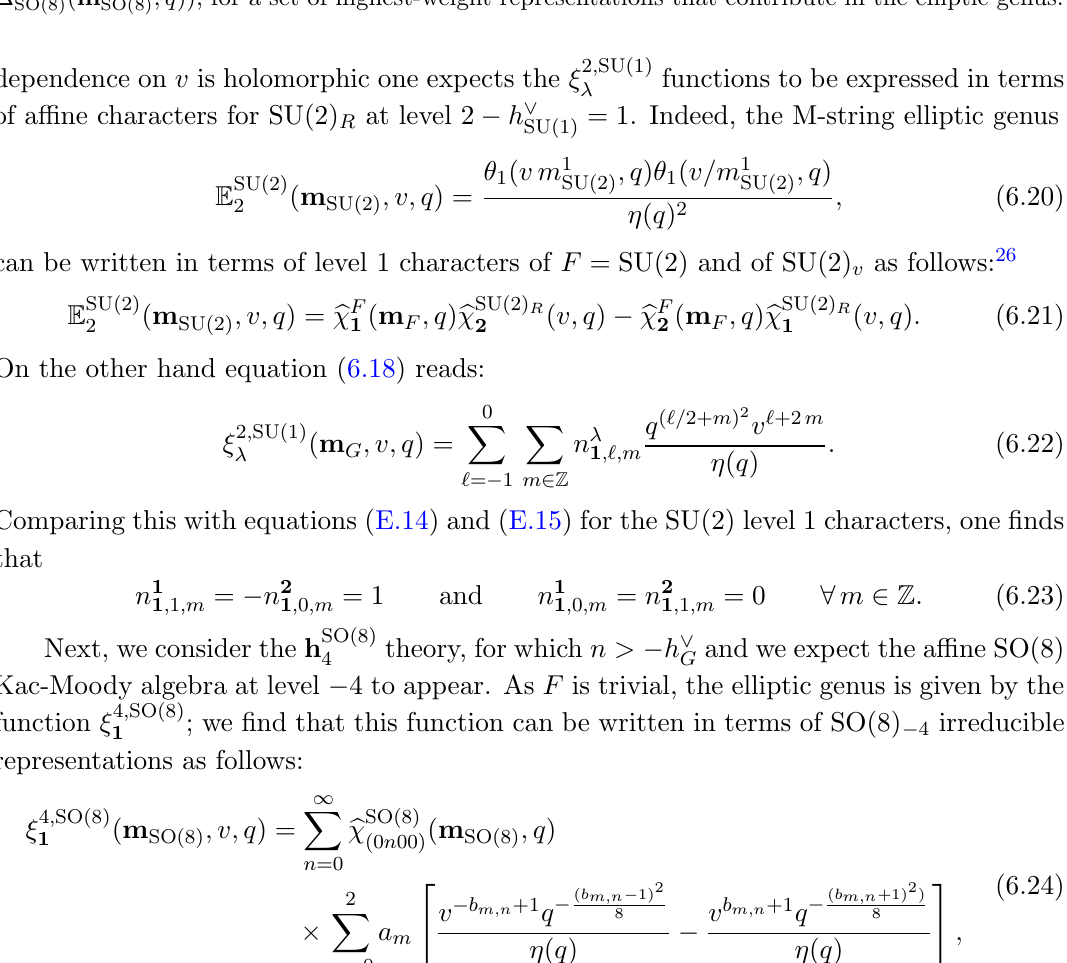
Table 18. Irreducible characters of SO(8) at level (cid:0) 4 (rescaled by an overall factor of e (cid:1) SO(8) ( m SO(8) ; q )), for a set of highest-weight representations that contribute in the elliptic